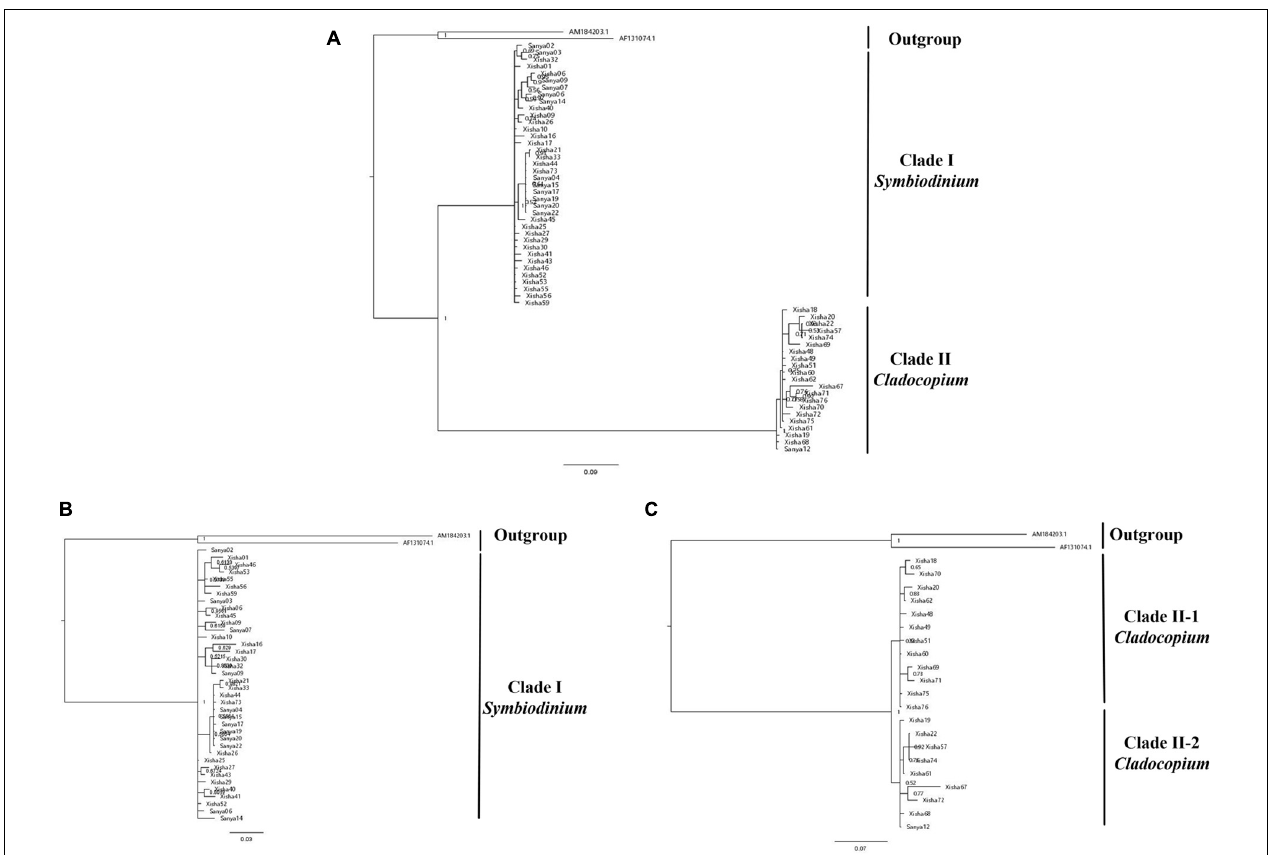
FIGURE 4 | BI tree of zooxanthellae based on ITS1 fragment. Numbers at nodes are posterior probabilities. (A) Phylogenetic tree of all the zooxanthellae individuals using Gymnodinium (AM184203) and Gyrodinium (AF131074) as outgroup and (B) Phylogenetic tree of Clade I, and (C) Phylogenetic tree of Clade II, derived from the phylogeny of all zooxanthellae individuals, using the same outgroup.